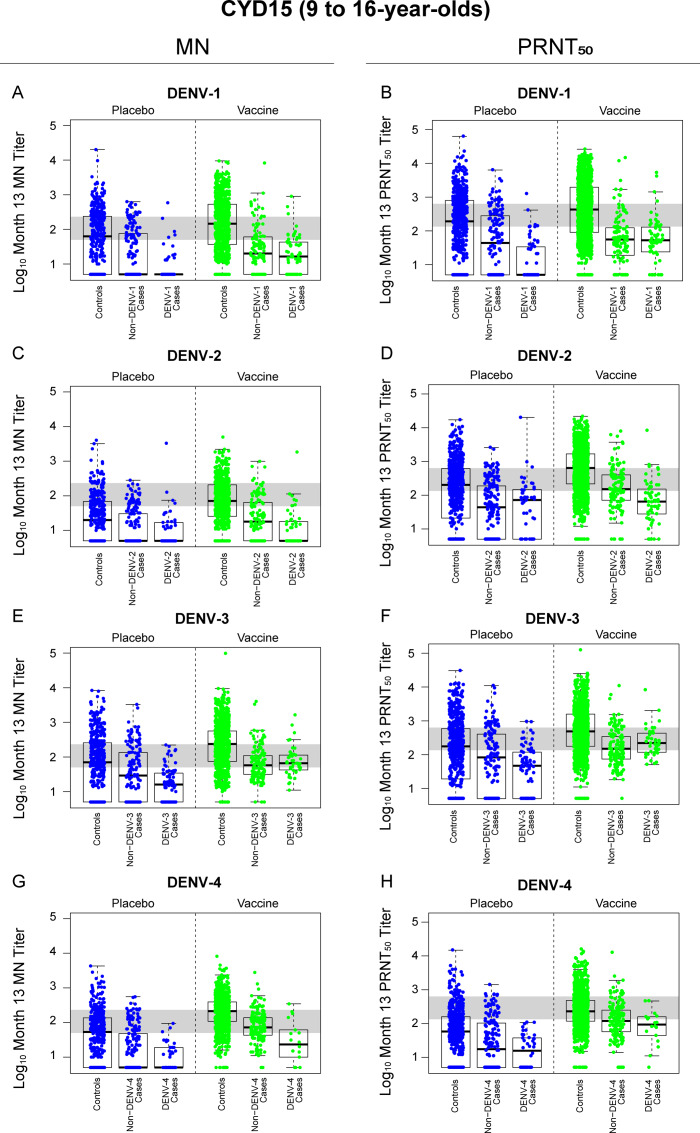
Distributions of log10 Month 13 MN (Panels A, C, E, G) and PRNT50 (Panels B, D, F, H) titers in CYD15 participants (all ages = 9 to 16 years old), stratified by treatment group and case status (serotype-matched vs serotype-mismatched cases).The gray horizontal shaded band denotes the middle third of nAb responses (log10 MN titer = 1.7 − 2.36; log10 PRNT50 titer = 2.13 − 2.8). A “matched-serotype case” is one where the VCD-causing virus was of the same serotype as the virus used in the nAb assay; a “nonmatched-serotype case” is one where the VCD-causing virus was of a different serotype than the virus used in the nAb assay.